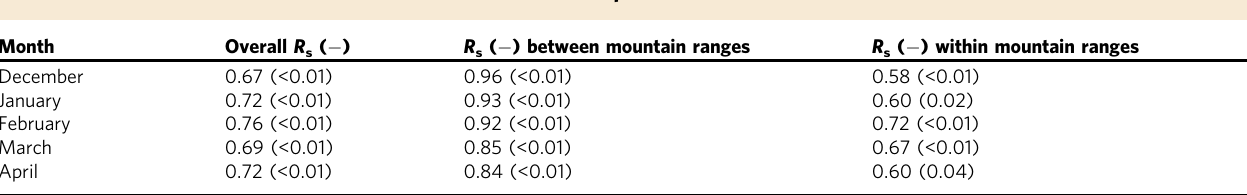
Table 2 Correlations between measured and retrieved snow depths Month R s ( − ) between mountain ranges R s ( − ) within mountain